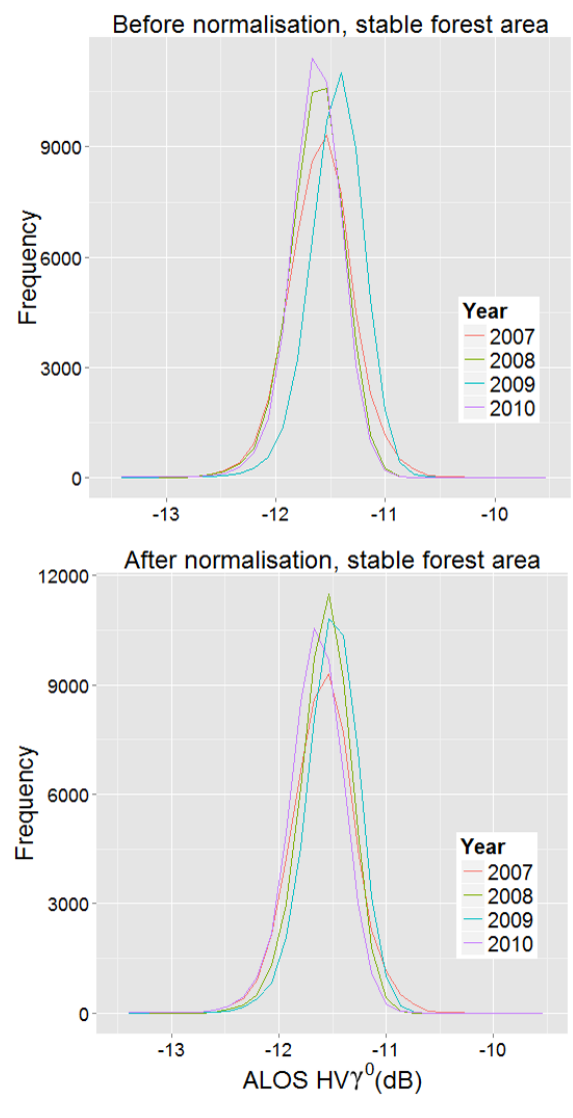
Figure 6. The figure displays the frequency distributions of HV backscatter (dB) before and after the relative normalisation proce- dure. These data are extracted from areas of stable core forest in Berbak National Park. The top figure displays interannual varia- tions in the pixel values over the stable (pseudo-invariant) forest, particularly in 2009 prior to the normalisation procedure. The bot- tom image shows how, this difference is greatly reduced and the dis- tributions converge after the normalisation procedure. This suggests that we have consistent backscatter values over time over unchang- ing forest and hence that any large changes in backscatter values per pixel between years may be attributed to significant changes in the SAR target, i.e. the clearance of